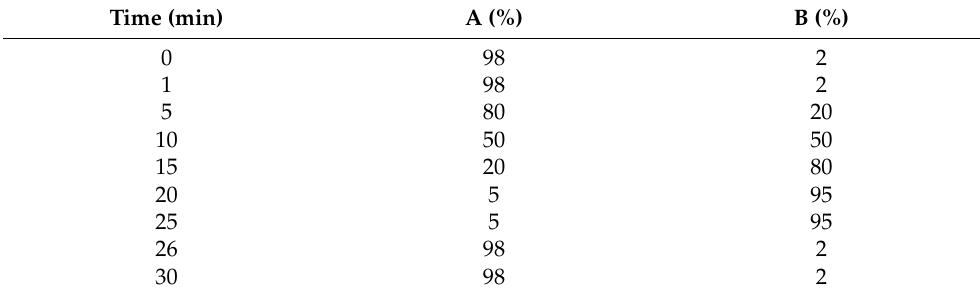
Table 3. Chromatographic gradient